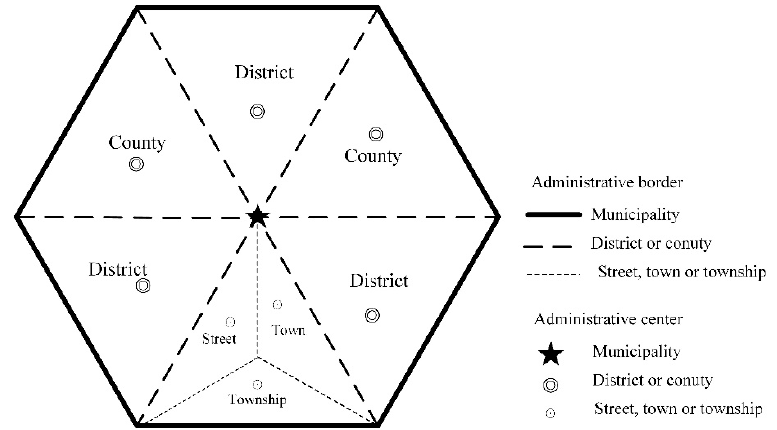
Figure 2. The administrative structure of a municipality in China.